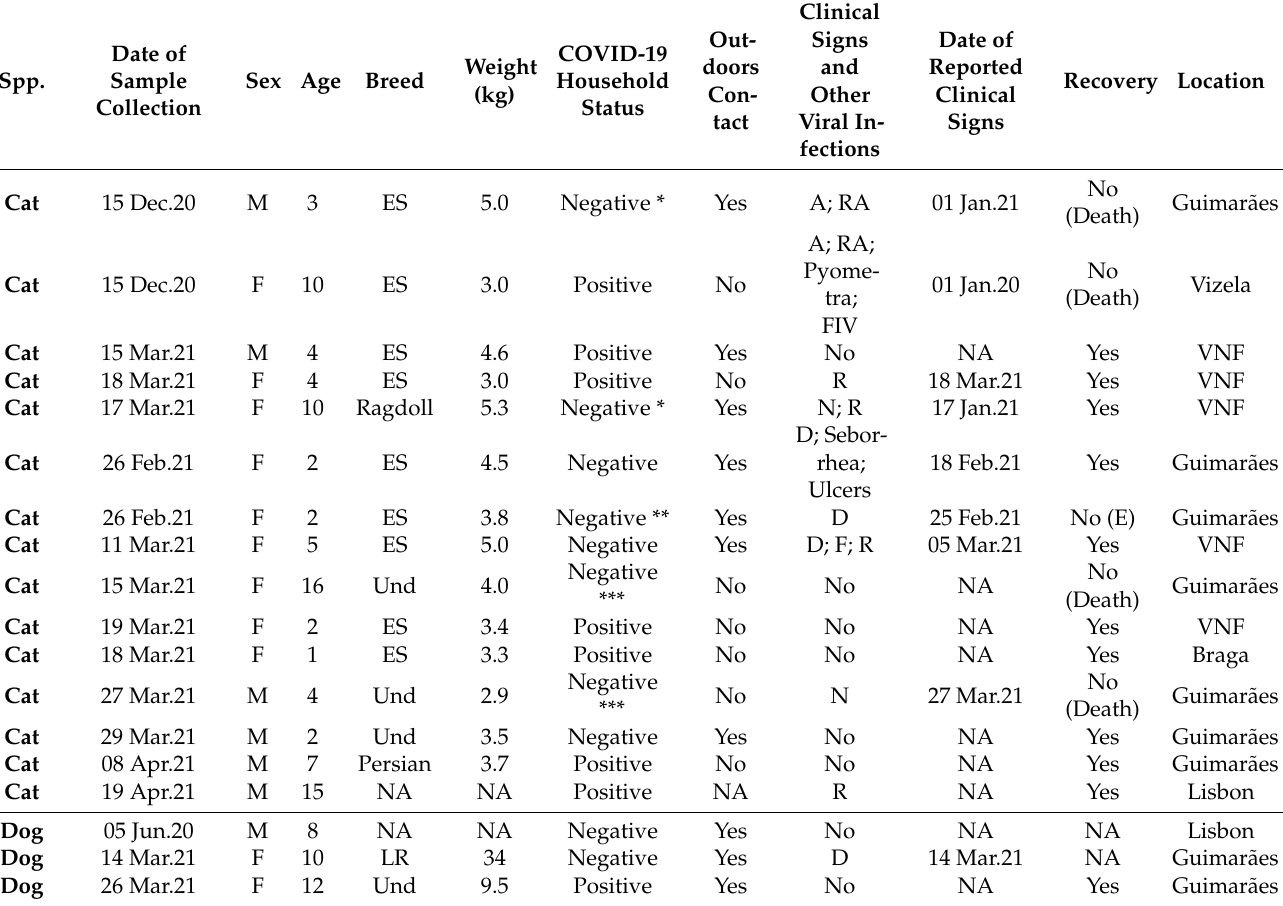
Table 1. Data from the SARS-CoV-2 seropositive